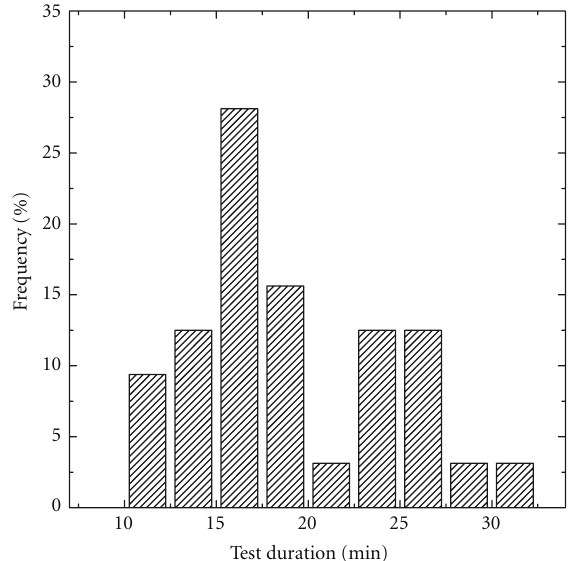
Figure 5: Distribution of total test duration for hearing-threshold estimationsin 32 subjects (16 normalhearing, 16 hearing impaired) using multiple ASSR with narrow-band chirps and adaptive stimu- lus